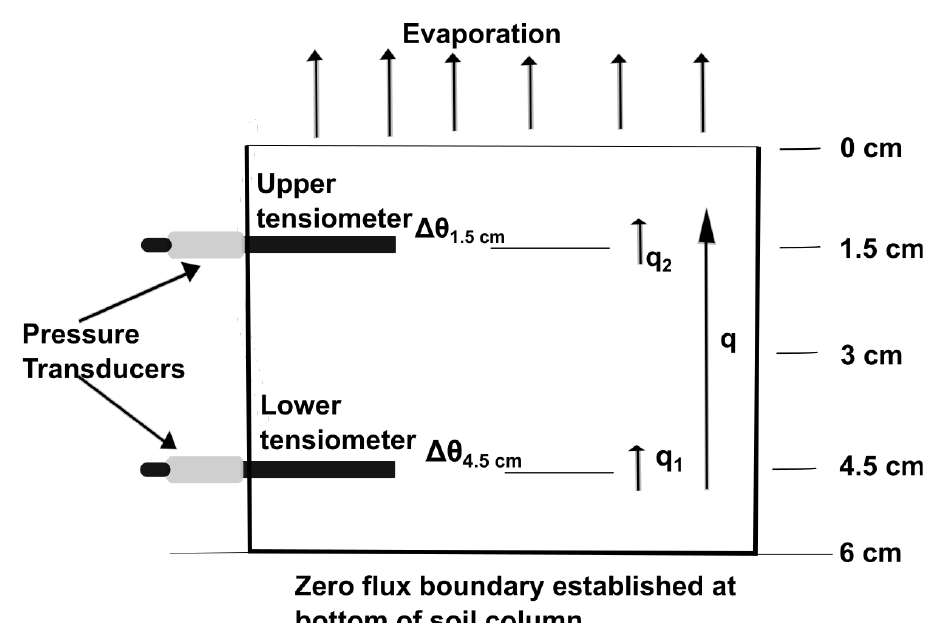
Figure 3. Schematic of the experimental set-up for determining the hydraulic conductivity of the hydrogel amended soils using the evaporation method, redrawn from Wendroth et al. [41], where q 1 and q 2 represent the upward volume flux density of water across the 4.5 cm and 1.5 cm boundaries, respectively, in the soil cores. The average upward volume flux density of water between the 1.5 and 4.5 cm boundaries is represented by q.